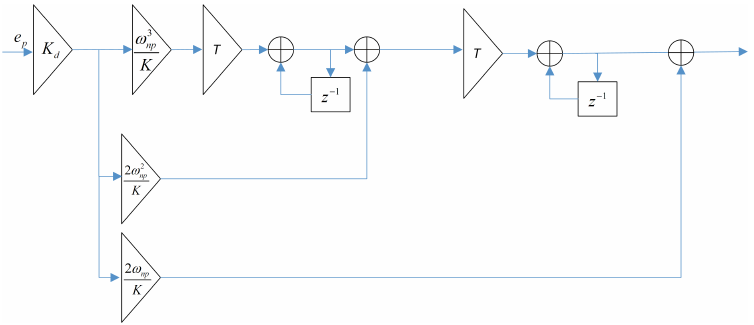
Figure 8. Structure diagram of digital loop filter of